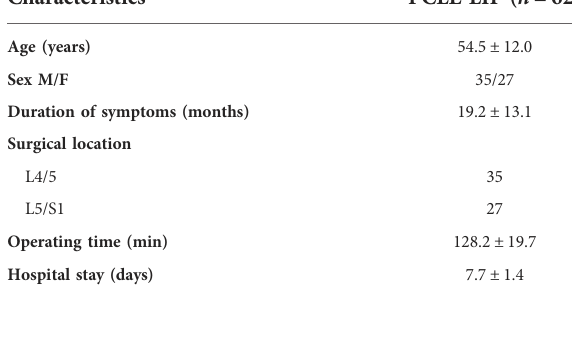
TABLE 1 Summary of the baseline data PCLE-LIF indicates percutaneous coaxial large-channel endoscopic lumbar interbody fusion; n indicates the total number of